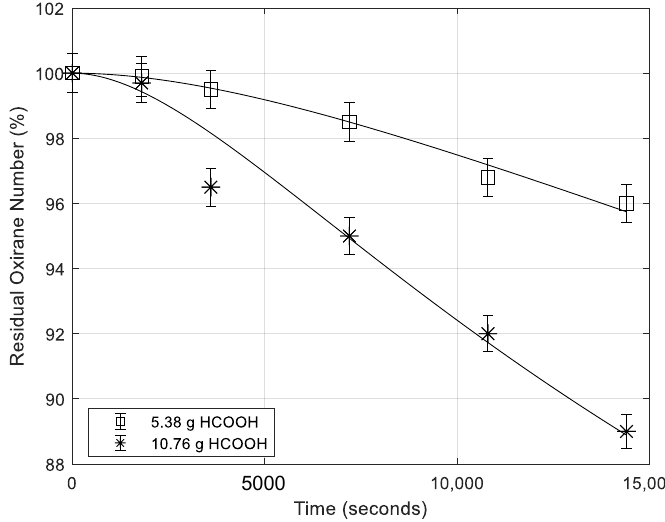
Figure 8. Residual oxirane profiles for different contents of formic acid being the same for all the other conditions (mass of catalyst 0.65 g; temperature 70 °C; rate of agitation 500 rpm). Points are experimental data lines that are calculated with the developed model.